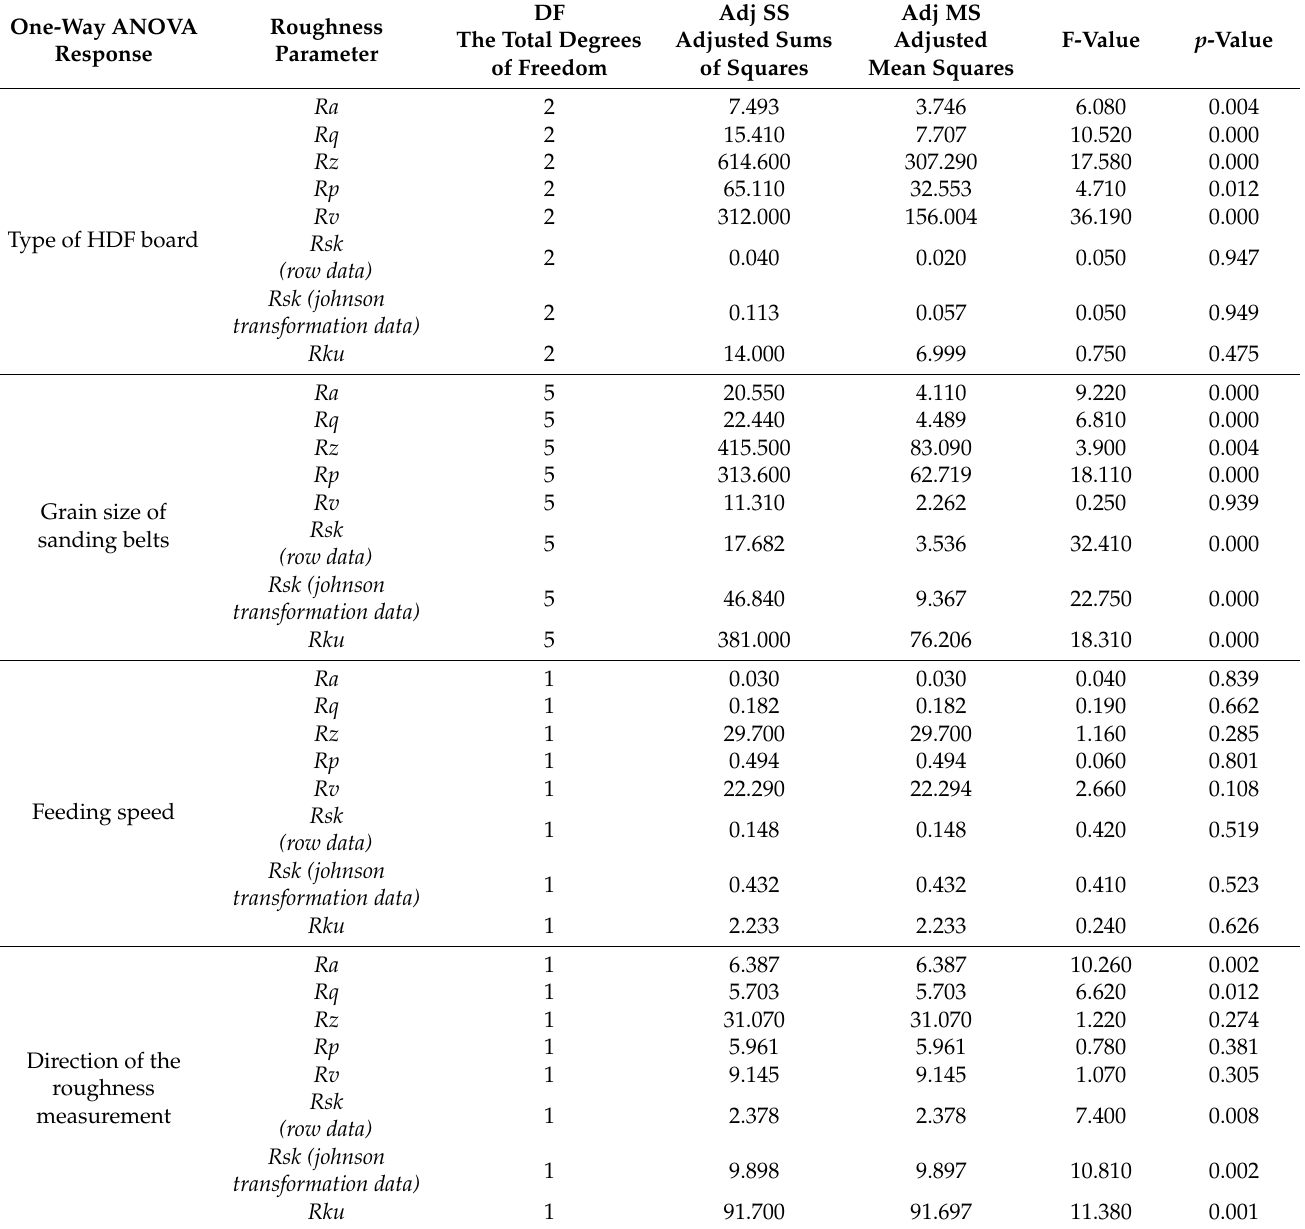
Table 3. One-way ANOVA analysis of roughness parameters (arithmetic mean deviation Ra , ge- ometric average roughness Rq , kurtosis of the roughness profile Rku , skewness of the roughness profile Rsk , the maximum peak height of the roughness profile Rp , the maximum valley depth of the roughness profile Rv , ten-point height Rz ) as a function of the